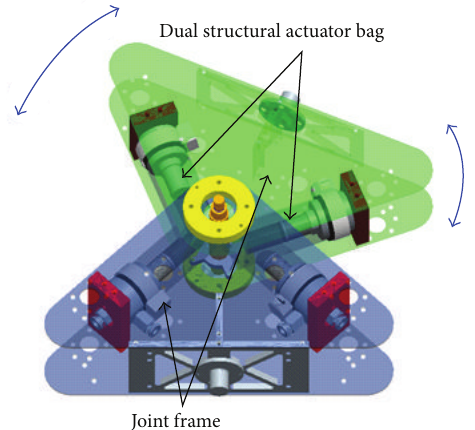
Figure 4: Schematic of the proposed joint